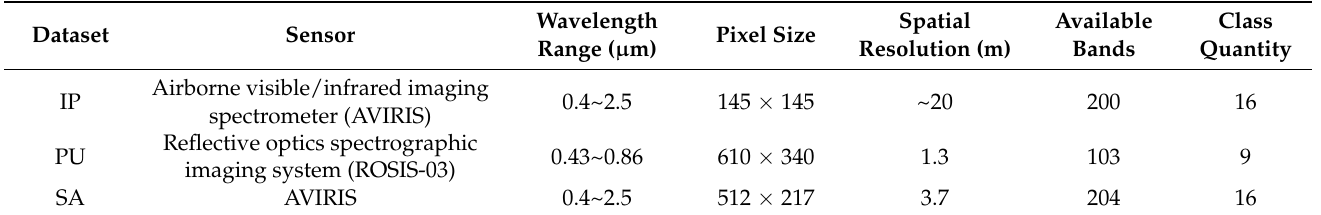
Table 1. Summary of three publicly available hyperspectral datasets: IP, PU, and SA *.